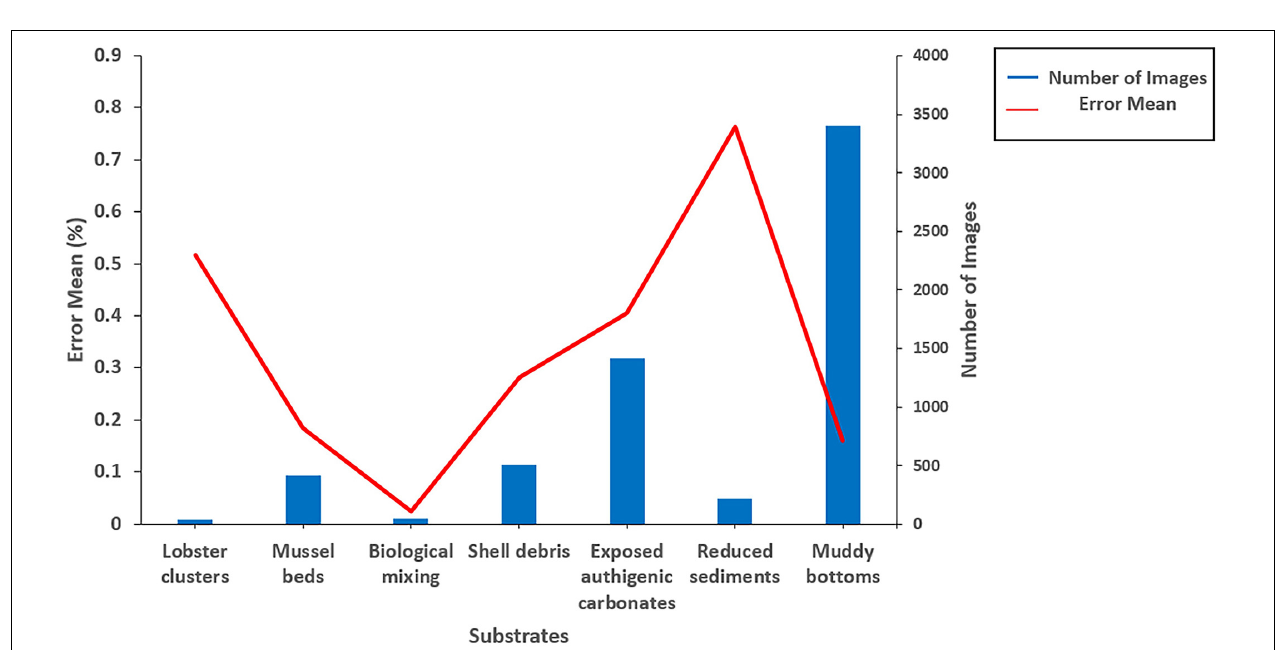
FIGURE 7 | Error means for different substrates.